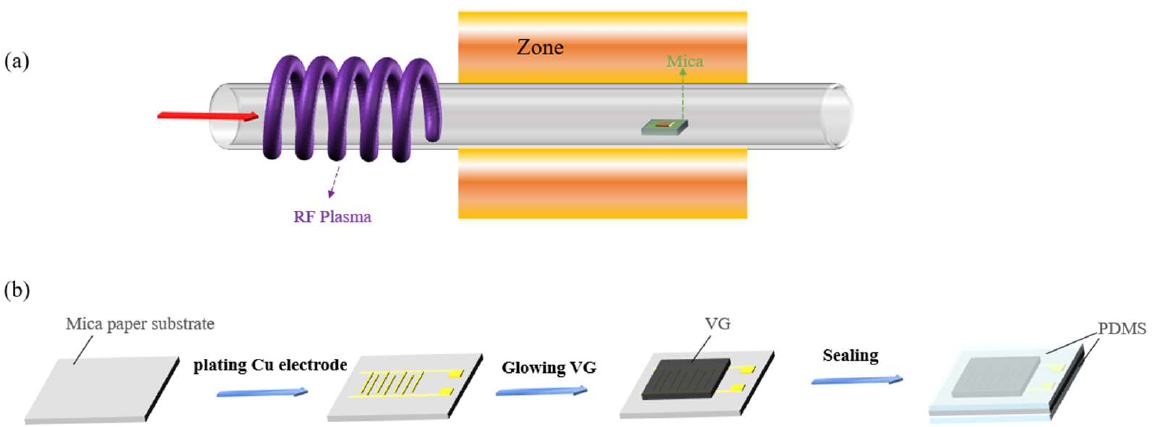
Figure 1. Preparation process of sensitive layer material and sensor: ( a ) schematic illustration of the growth of vertical graphene(VG) in plasma-enhanced chemical vapor deposition (PECVD); ( b ) fabrication procedure of the flexible vertical graphene-based (VG-based) pressure sensor.